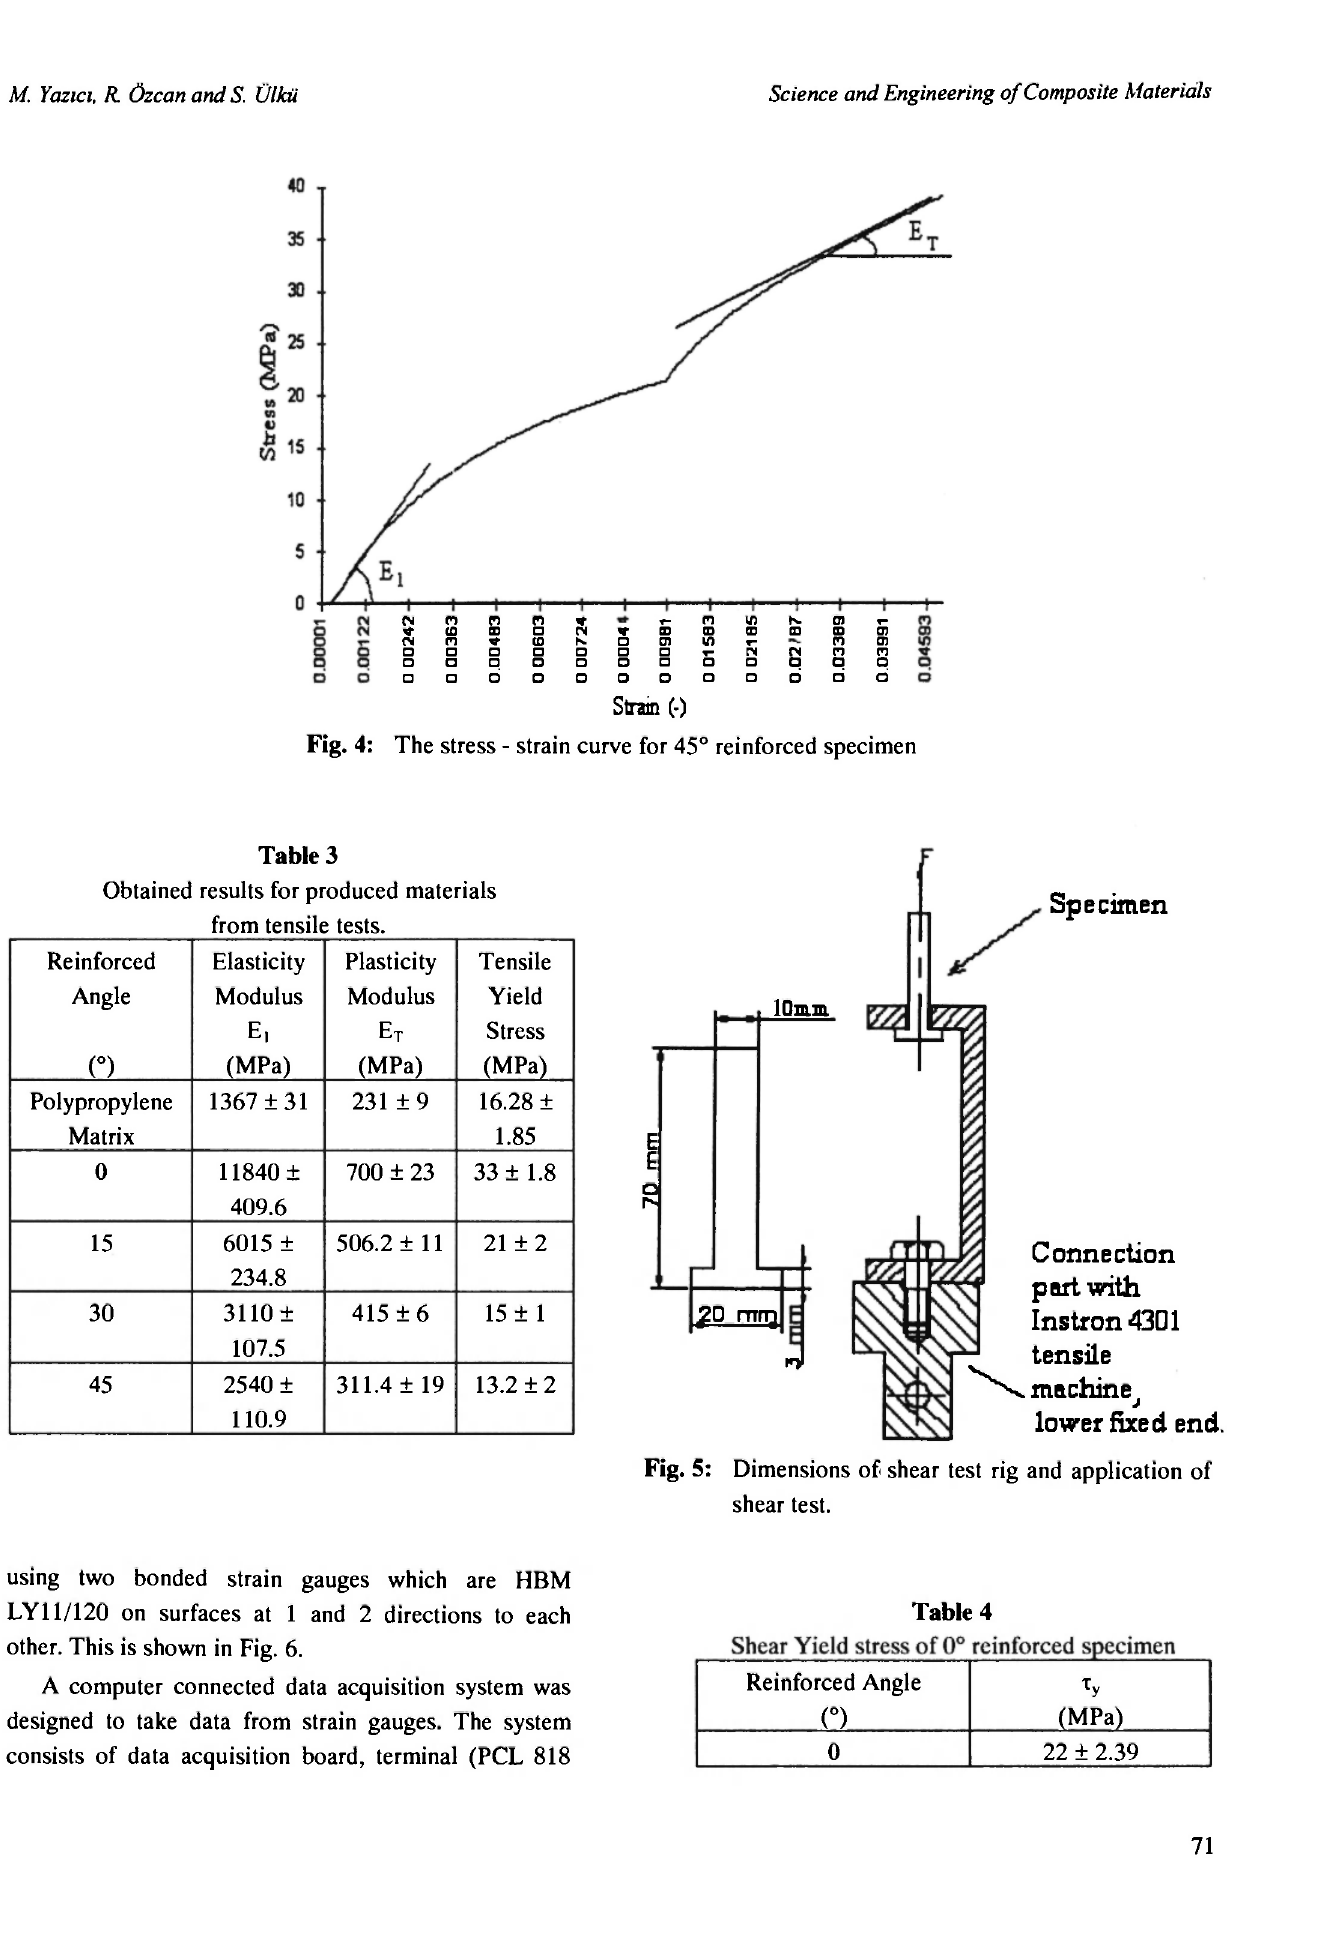
Fig. 4: The stress - strain curve for 45° reinforced specimen